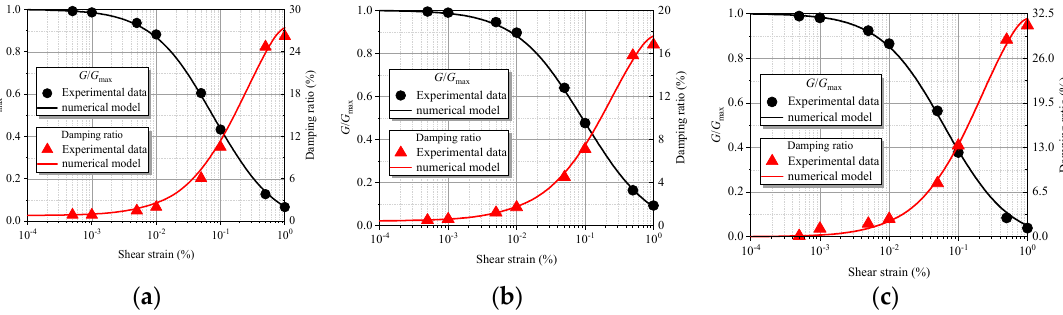
Figure 5. Comparison between numerical model predictions and experimental data for ( a ) clay, ( b ) sand, and ( c ) muddy clay. Table 1. Fitting parameters for different types of soil.